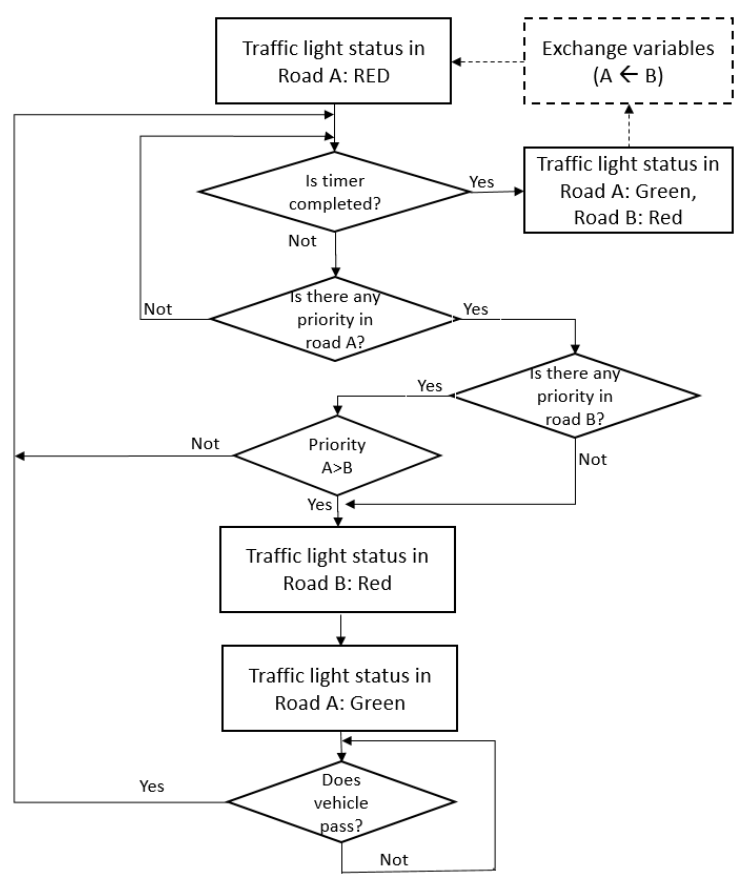
Figure 7. The proposed control algorithm for an intelligent traffic